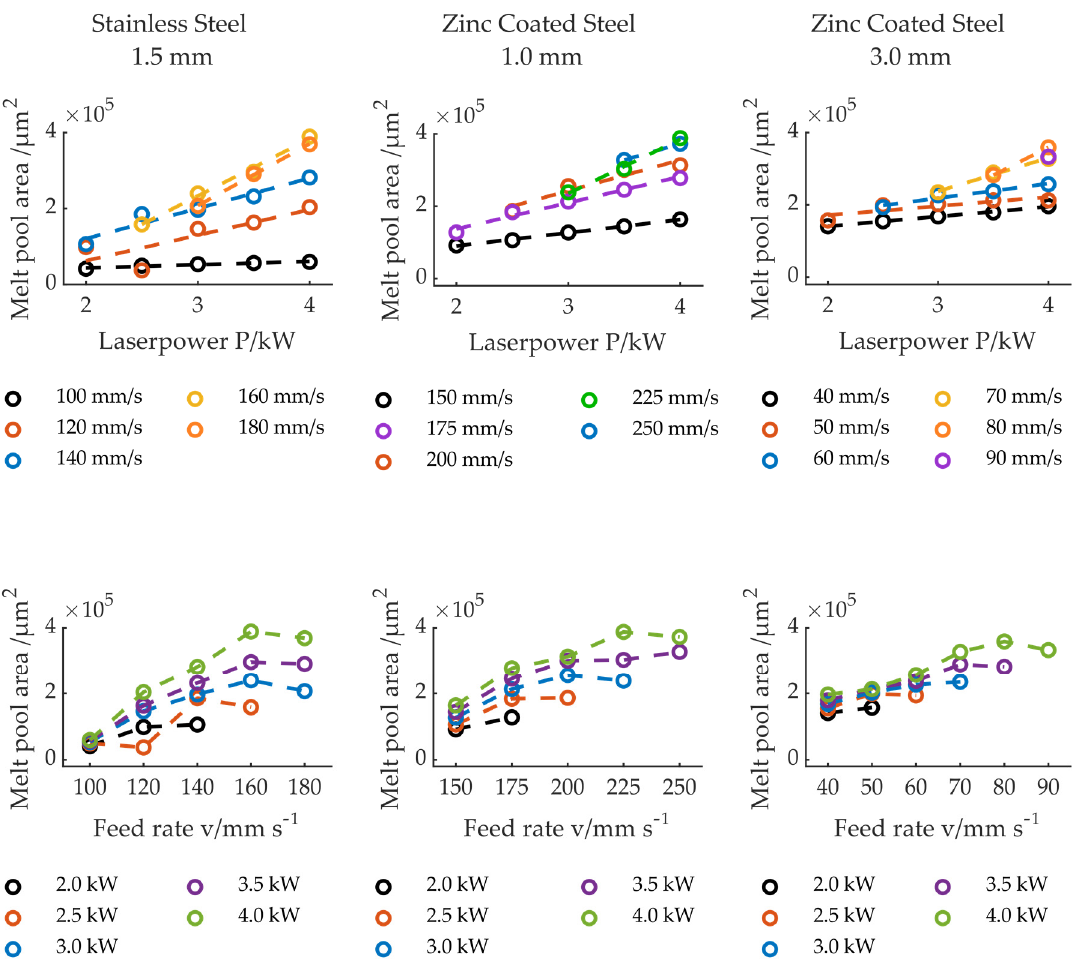
Figure 7. Average size of the melt pool area depends on the laser power and feed rate for 1.5 mm thick stainless steel, 1.0 mm, and 3.0 mm zinc-coated steel.